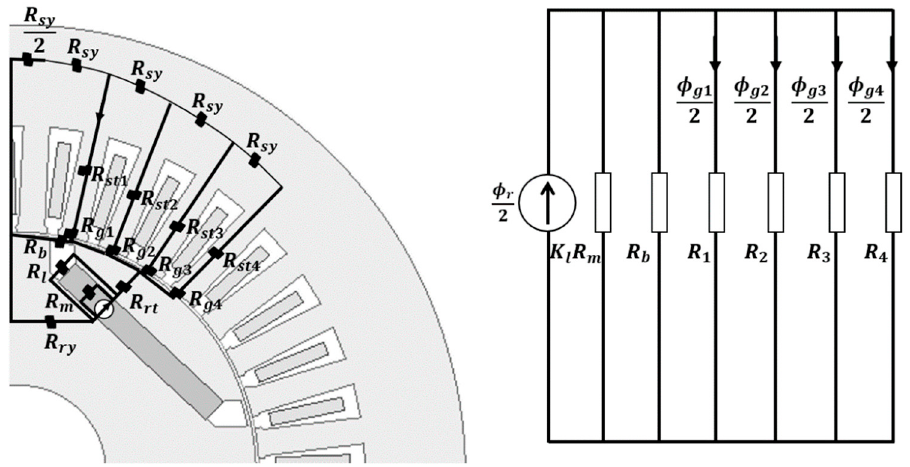
Figure 5. Magnetic equivalent circuit of a permanent magnet with slots.